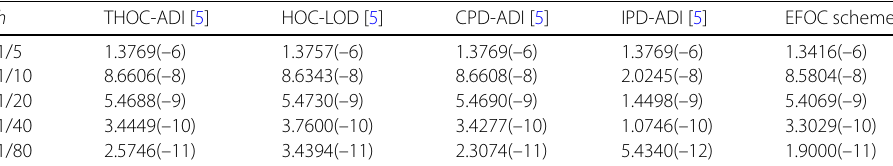
Table 2 The L ∞ norm error with τ = 0.0025 at t = 1 for different h for Problem 1 h